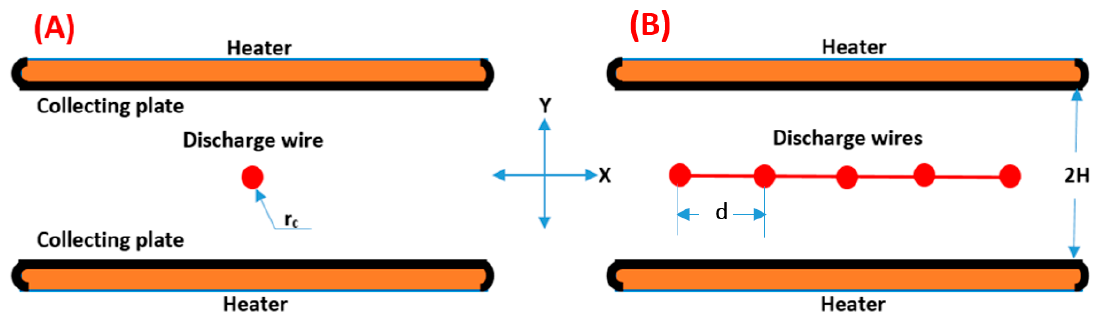
Figure 1. Configuration of the wire-duct electrostatic precipitators (WDESP): ( A ) single-discharge wire and ( B ) multi-discharge wires.